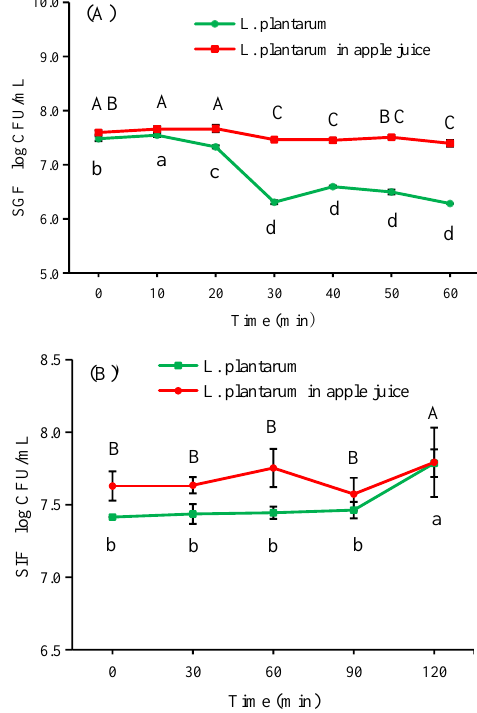
Figure 8. Variations of viability of L. plantarum suspension and L. plantarum in fermented apple juice under simulated gastric fluid ( A ) and simulated intestinal fluid ( B ) conditions. Experiments were performed in triplicate; vertical bars indicate ± SD ( p < 0.05). Different small letters and capital letters indicate significant differences ( p < 0.05) of L. plantarum suspension and L. plantarum in fermented apple juice, respectively.